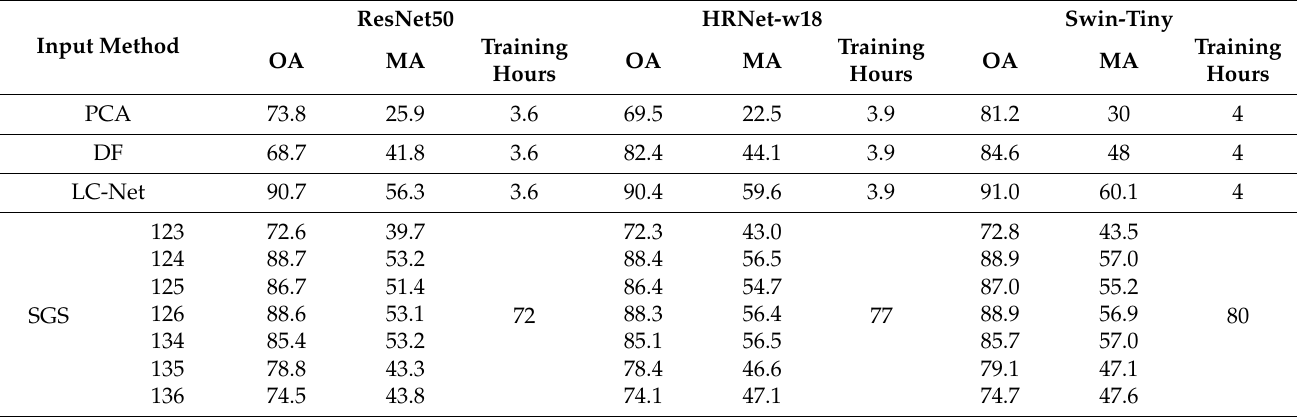
Table 5. Comparison of accuracies and computational cost using PCA, DF, LC-Net, and SGS (%). The numbers shown in the “Input Method” column for SGS indicate which three bands were used as the input images to the subsequent